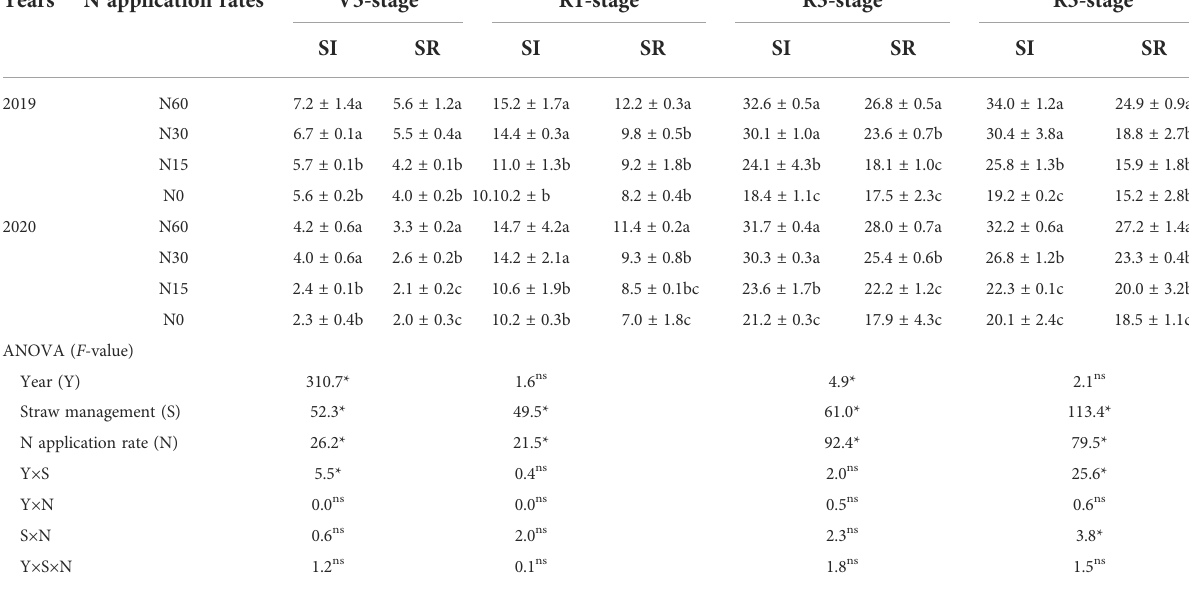
TABLE 4 Effects of straw incorporation and nitrogen application on root volume of intercropped soybean at different growth stages (cm 3 plant -1 ).